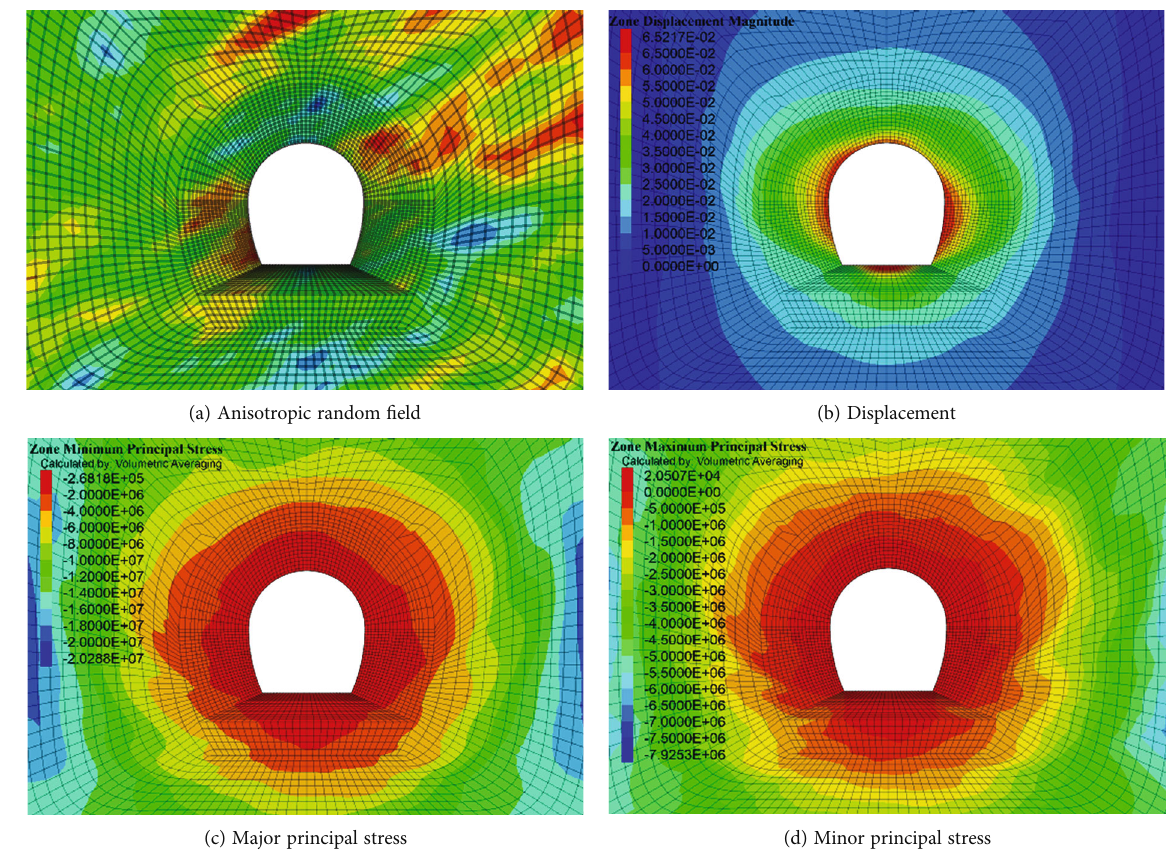
Figure 11: Analysis of cavern excavation results with 30 ° anisotropic fi